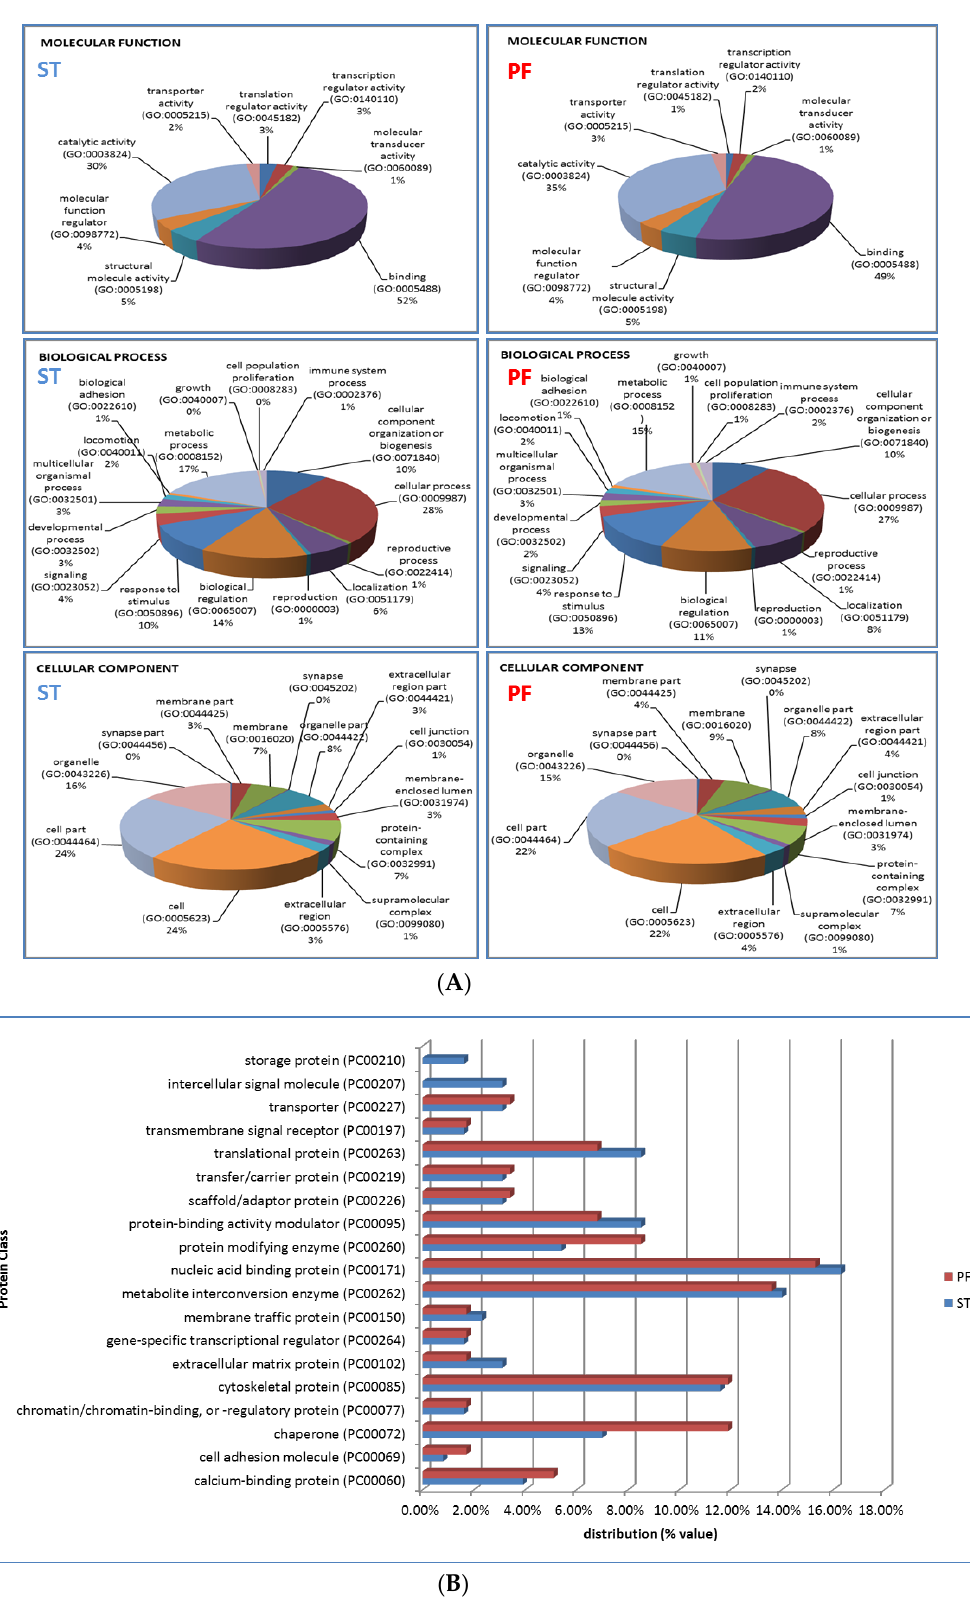
Figure 7. ( A ) Molecular function, biological process, and cellular component gene ontology (GO) classification of the 191 and the 83 cancer related protein lists common to ST- and PF-EP specimens, respectively. ( B ) Protein class GO classification of the 191 and the 83 cancer related protein lists common to ST- and PF-EP specimens, respectively.